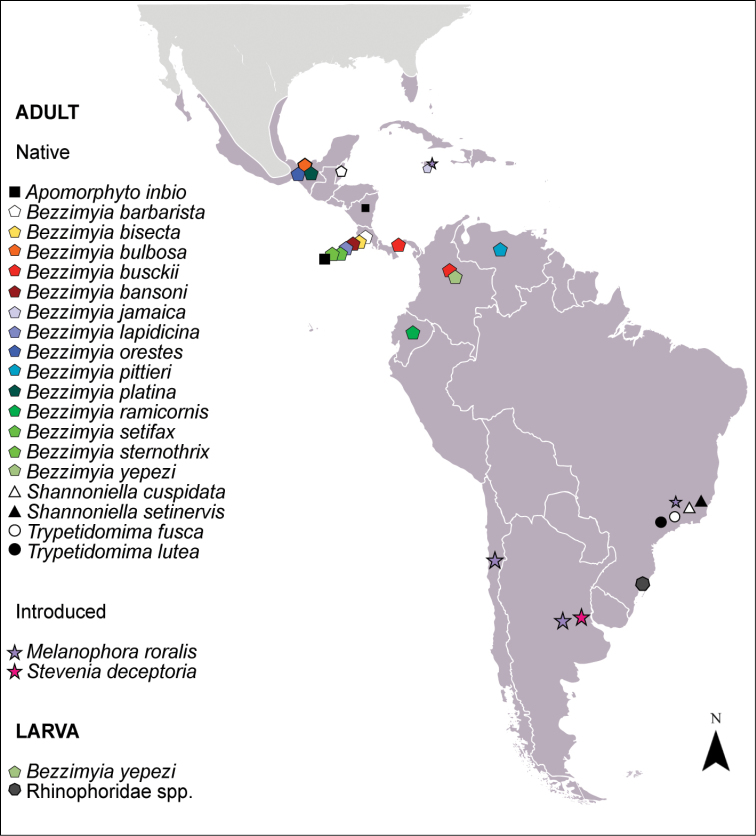
Distribution map of native and introduced Rhinophoridae species in the Neotropical region (area in gray) including the new larvae record. Apomorphytoinbio records from Pape (2010) and Cerretti et al. (2014); Bezzimyia spp. records from Pape and Arnaud (2001); Shannoniella spp. records from Nihei et al. (2016); Trypetidomima spp. records from Nihei and Andrade (2014); Melanophoraroralis records from Parker (1953), Guimarães (1977), González (1998), Cerretti and Pape (2009) and Mulieri et al. (2010); Steveniadeceptoria records from Mulieri et al. (2010). Base map modified from: commons.wikimedia.org/